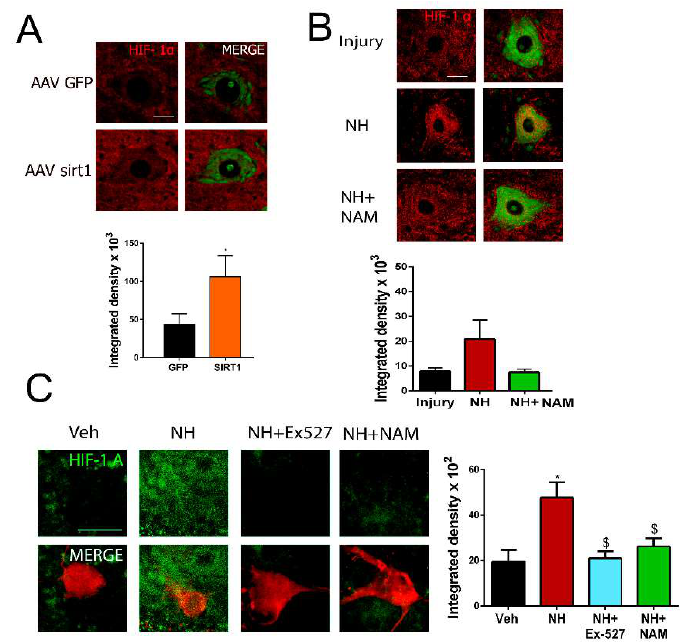
Figure 4. SIRT1 activity stabilizes HIF1 α in motoneurons ( A ) Representative confocal images of MNs stained with HIF1- α FluoroNissl green from the di ff erent groups and associated bar graphs of the mean ( ± SEM) intensity for each marker inside the cytoplasm of injured MNs from AAVrh10-GFP or AAVrh10-SIRT1 animals. (n = 4 animals per group, t -test, * p < 0.05 vs. AAV-GFP) Scale bar = 20 µ m. ( B ) Representative confocal images of Hif-1 α (red) counterstained with FluoroNissl (green) in MNs from the di ff erent groups at 60 dpi. Scale bar = 20 µ m Bottom , a bar graph of the mean ( ± SEM) intensity for Hif1-1 α inside the cytoplasm of injured MNs at 60 dpi (n = 3–4, ANOVA, post hoc Bonferroni). Scale bar = 20 µ m ( C ) Left , Representative confocal images of HIF-1 α (green) counterstained with RT-97 (red) of MNs from SOCs of di ff erent conditions. Scale bar = 20 µ m. Right , Bar graphs of the mean ( ± SEM) intensity for each marker inside the cytoplasm of MNs (n = 10–18, ANOVA, post hoc Bonferroni, * p < 0.05 vs. Veh, $ p < 0.05 vs.